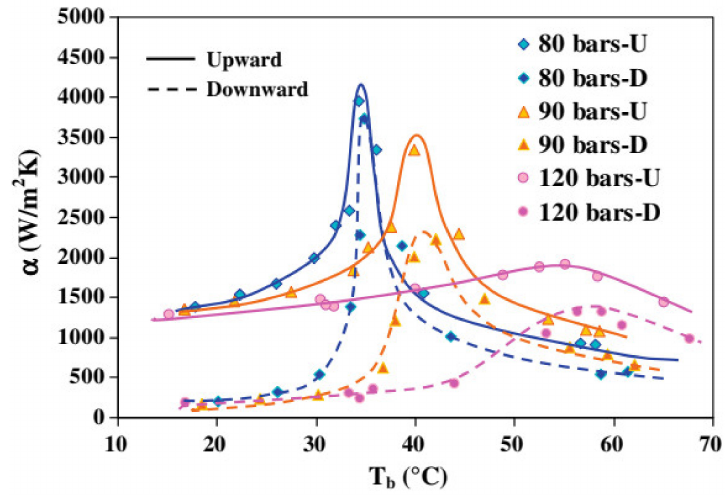
Figure 9. Comparison of heat transfer coefficient for upward and downward flows [29].